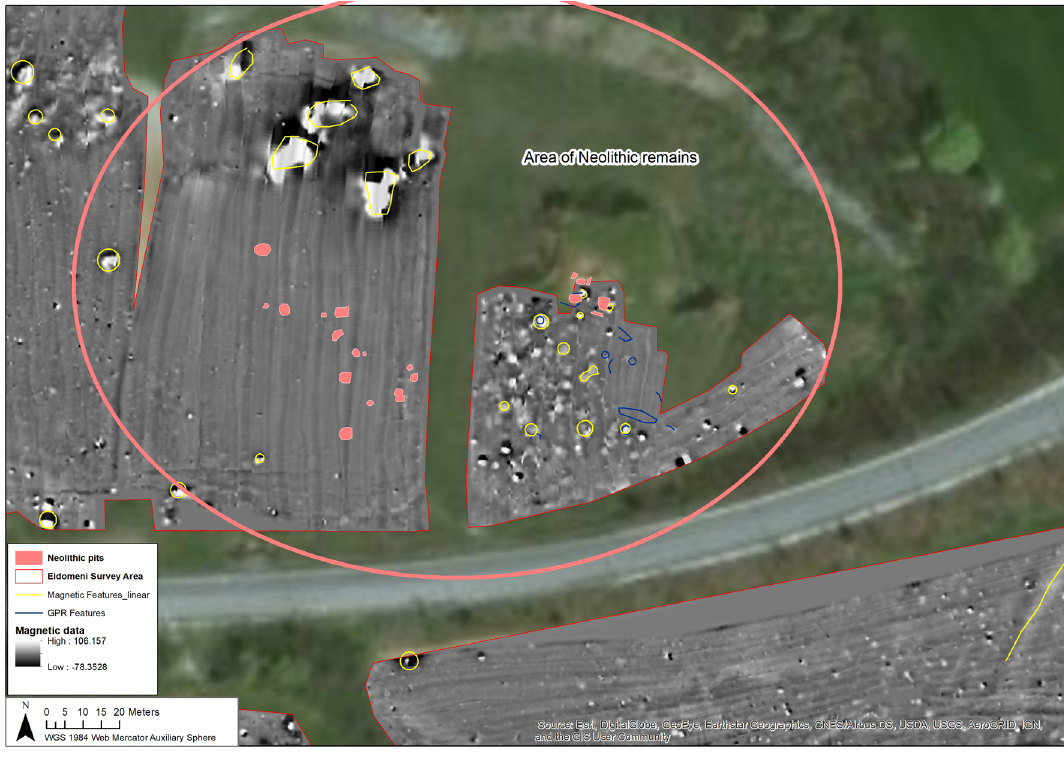
Figure 9. Structural (pit like) features in the area of the Neolithic site at Idomeni (WGS 1984, WebMercator Auxiliary